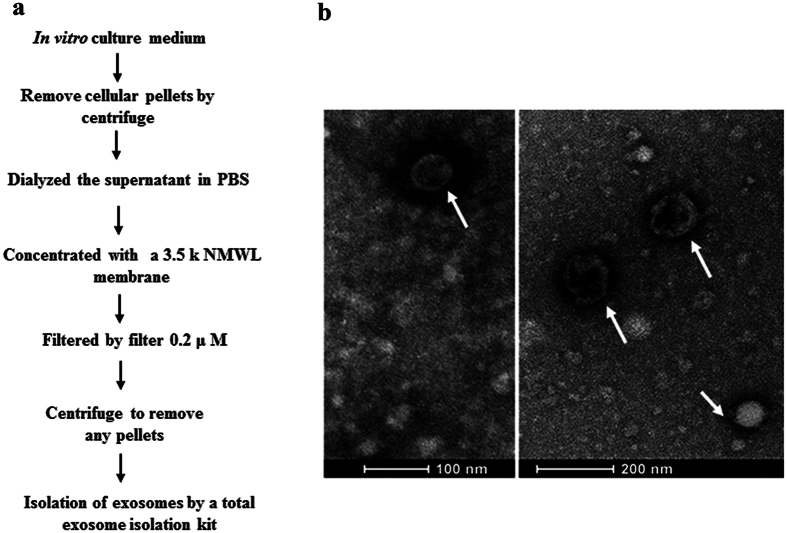
(a) Flow chart of S. japonicum EVs isolation from cultured medium. (b) Morphological characterization of S. japonicum EVs. Arrows indicate isolated S. japonicum EVs stained using uranyl acetate.